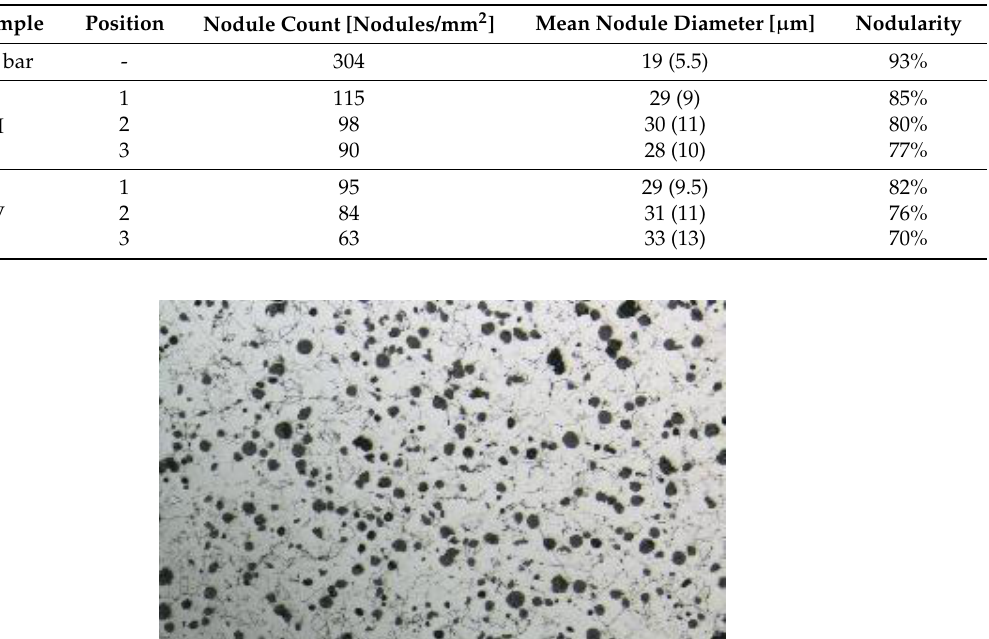
Table 6. Microstructural properties of samples. Mean values and standard deviation (in brackets).